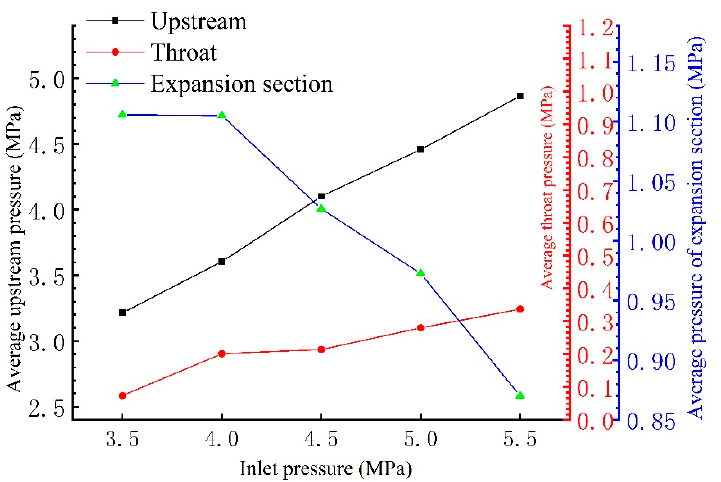
Figure 10. The average values of pressure fluctuation at three measuring points under increasing inlet pressures.